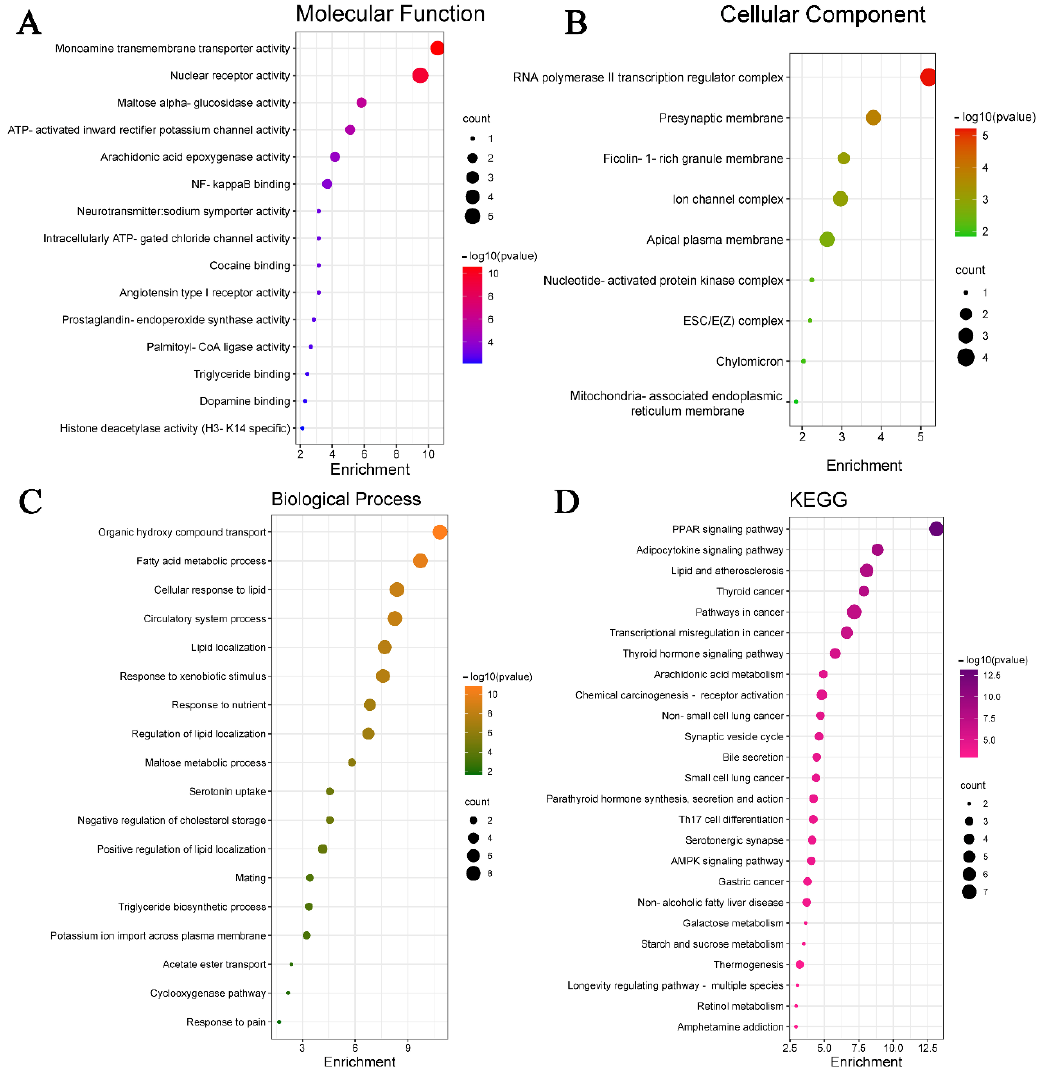
Figure 3. Molecular function pathway ( A ), cellular component pathway ( B ), biological process pathway ( C ) and KEGG pathway ( D ) analysis of the therapeutic targets of Scutellariae Radix in treating diabetes.